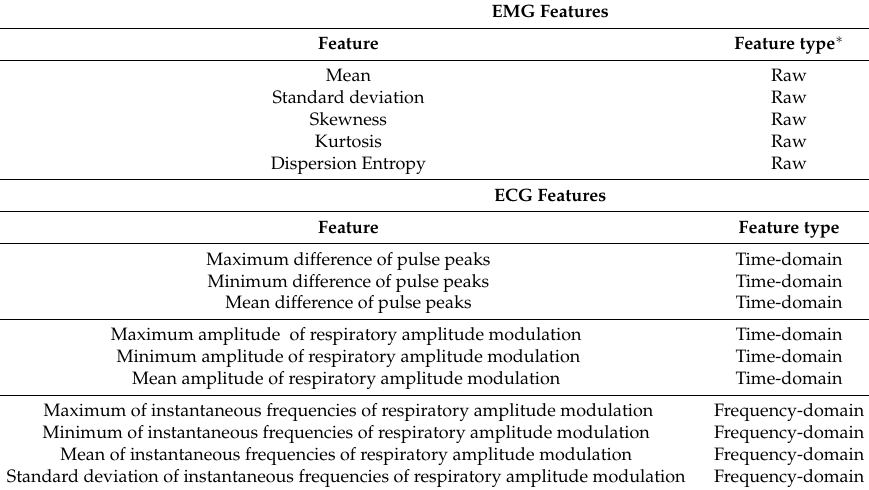
Table 1. A summary of features extracted from EMG and ECG signals is provided